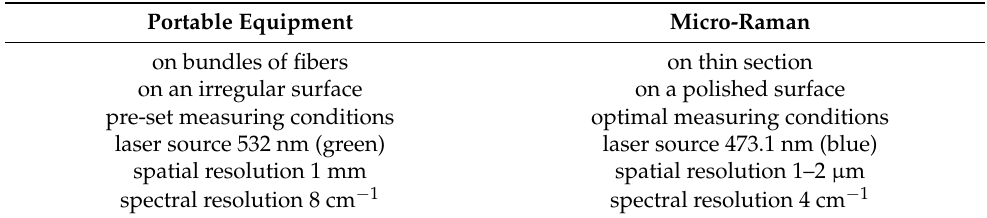
Table 2. Working conditions of portable Raman device (on the left) compared to benchtop high- resolution micro-Raman spectrometer (on the